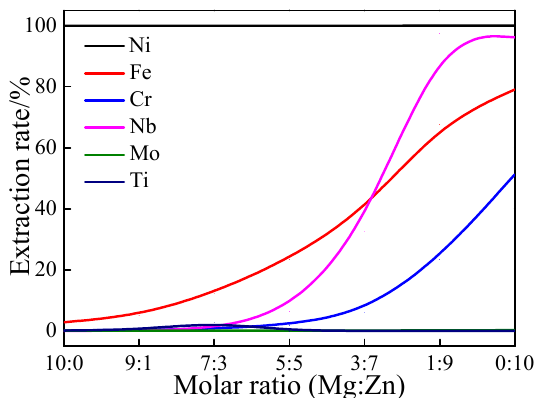
Figure 9. FactSage simulation on the extraction of metals from superalloy using a different molar ratio of Mg to Zn at 800 °C [32]. (In the calculation process, it was assumed that the masses of the initial superalloy and Mg-Zn alloy were 100 g and 500 g, respectively; liquid 1# in the Factsage calculation results was adopted.).